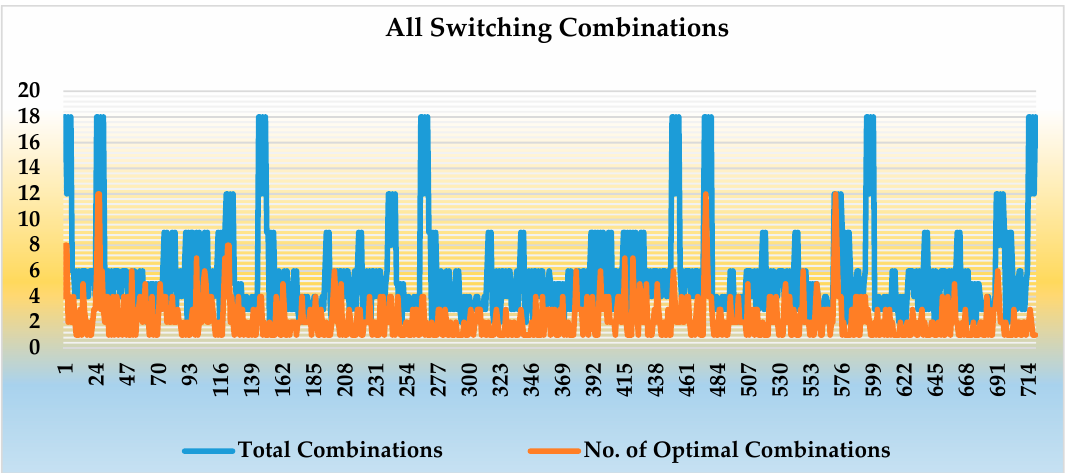
Figure 9. Number of total and optimal switching combinations in optimized HCROS .